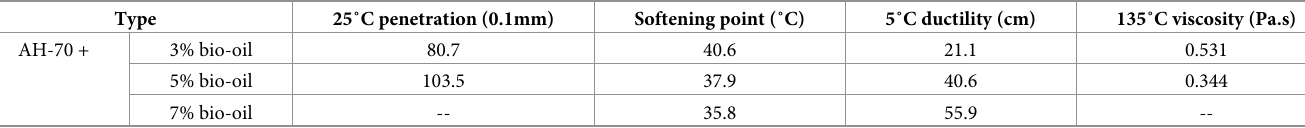
Table 5. Technical properties of bio-asphalt